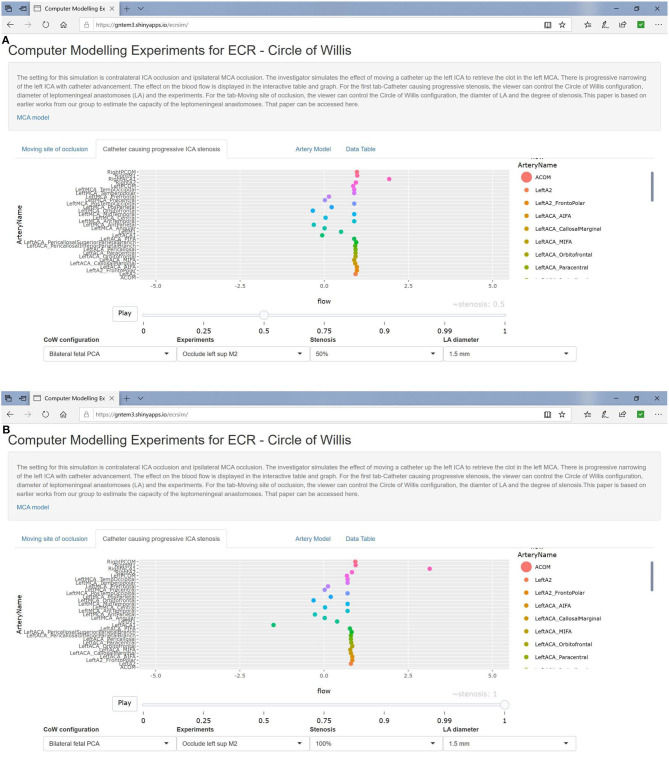
Simulated catheter movement on the left ICA show mild reduction in flow in the MCA branches at 50% stenosis (A) and at 100% stenosis (B).